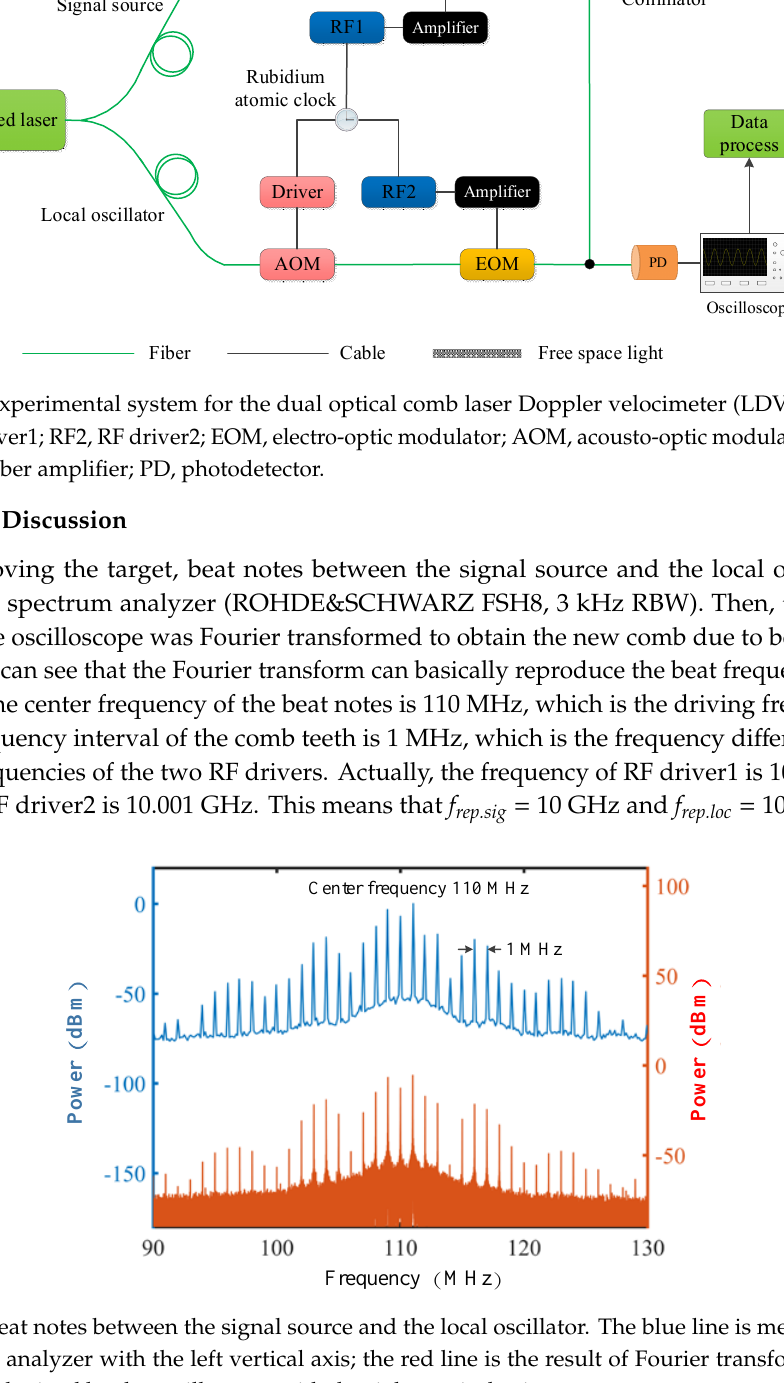
Figure 2. Beat notes between the signal source and the local oscillator. The blue line is measured by a spectrum analyzer with the left vertical axis; the red line is the result of Fourier transforming the waveform obtained by the oscilloscope with the right vertical axis.